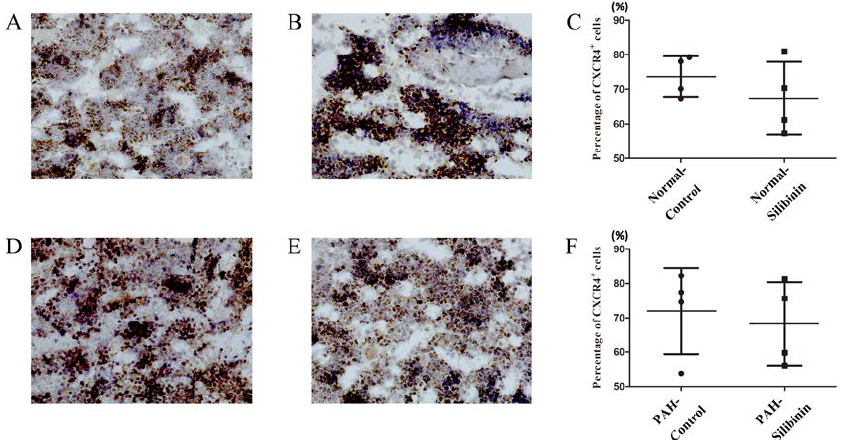
Figure 5. Immunohistochemical evaluation of CXCR4 in BM of normal and PAH rats. ( A – B ) CXCR4-positive cells in normal rats without ( A ) or with ( B ) silibinin. ( C ) No significant difference was observed in these groups. ( D – E ) CXCR4-positive cells were observed in PAH rats both without ( D ) and with ( E ) silibinin. ( F ) No significant difference was observed in these groups. Each group consisted of four rats.